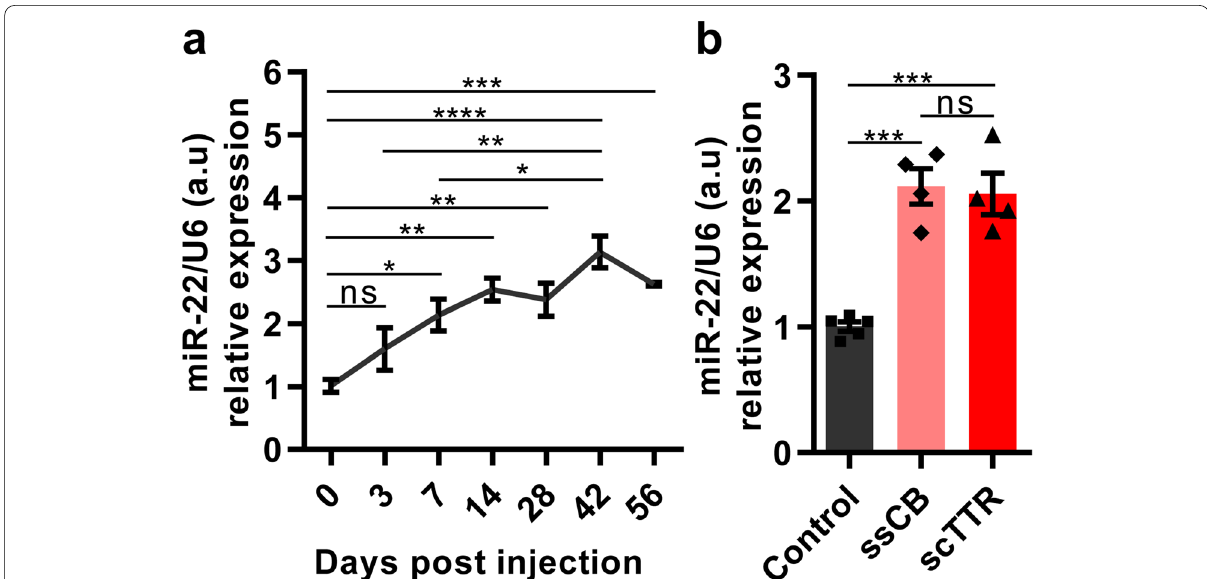
Fig. 5 rAAV-mediated overexpression of miR-22 in mouse livers. a A miR-22 overexpression time course in the mouse livers mediated by the single-stranded rAAV vector, AAV8-CB-miR-22 vector (ssCB). b Comparison of miR-22 expression levels in the livers of ssCB and scTTR mice. n all data were reported as mean